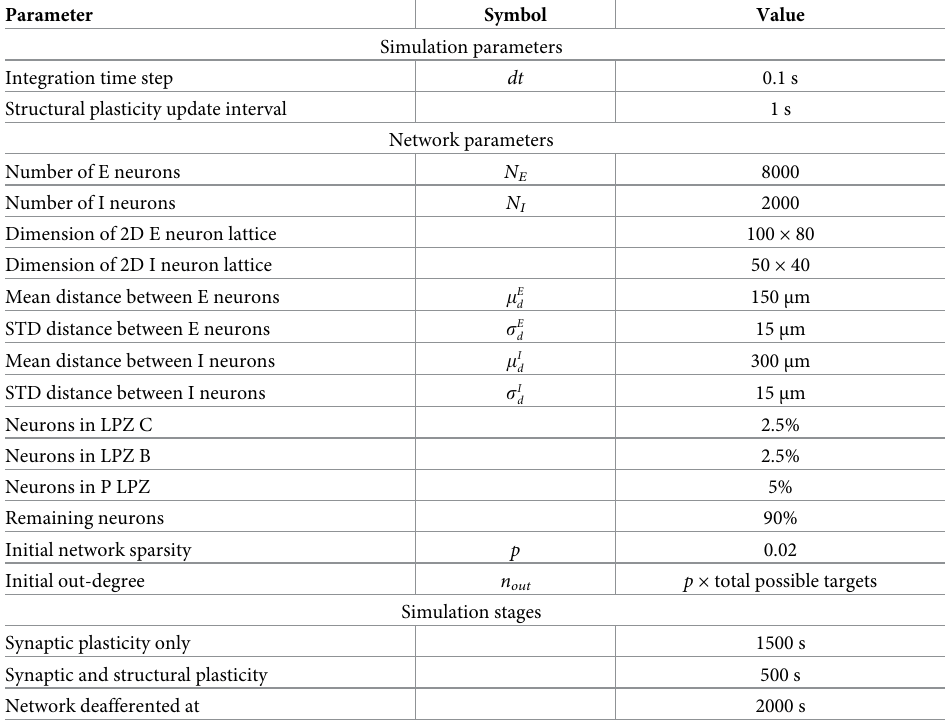
Table 5. Network simulation